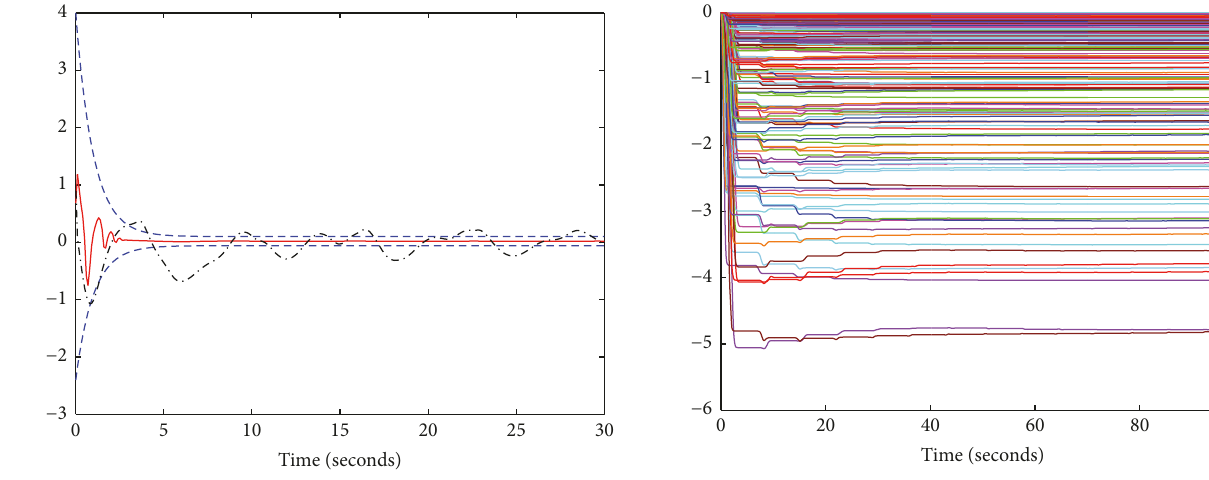
Figure 5: Angular velocity tracking error 𝑒 22 : ANC with error transformation method (—), ANC method in [30] (- ⋅ - ⋅ ), and the error bounds (- - -).